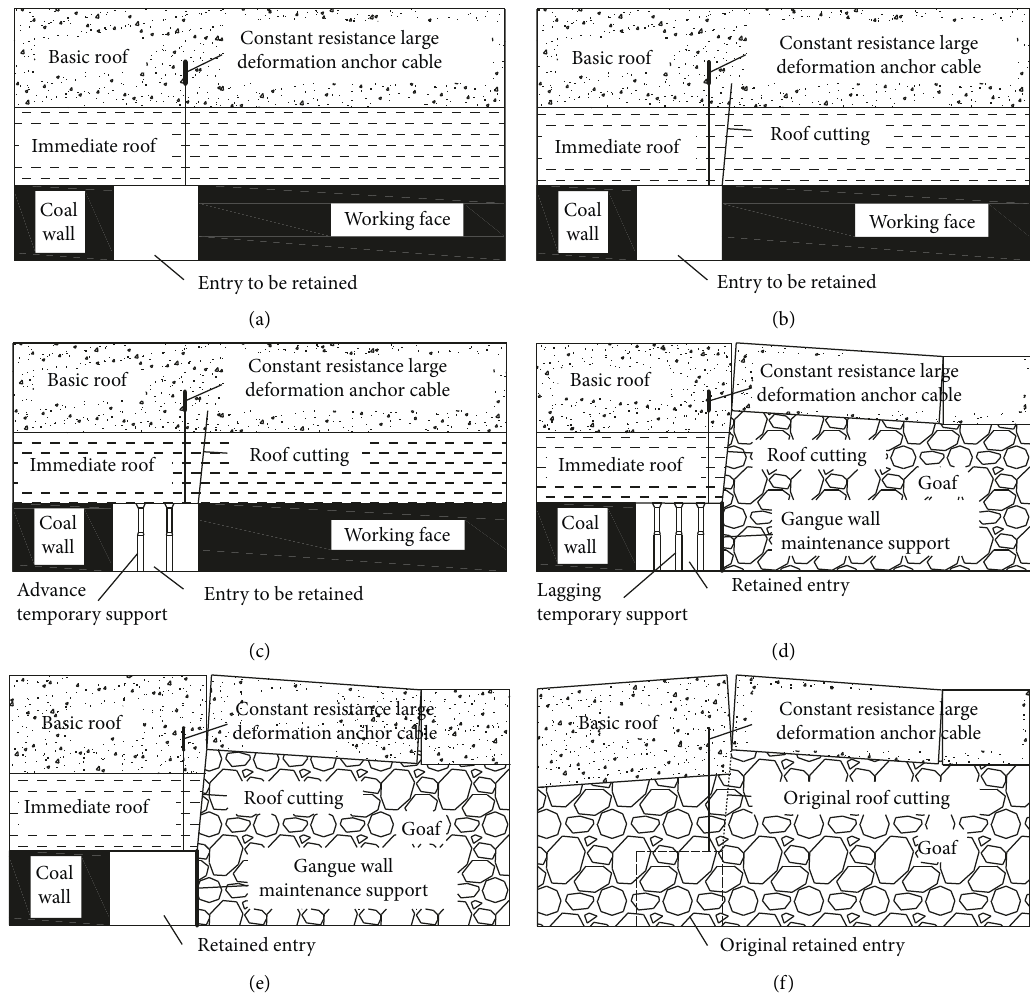
Figure 2: Technological process of roof cutting pressure releasing gob-side entry retaining.